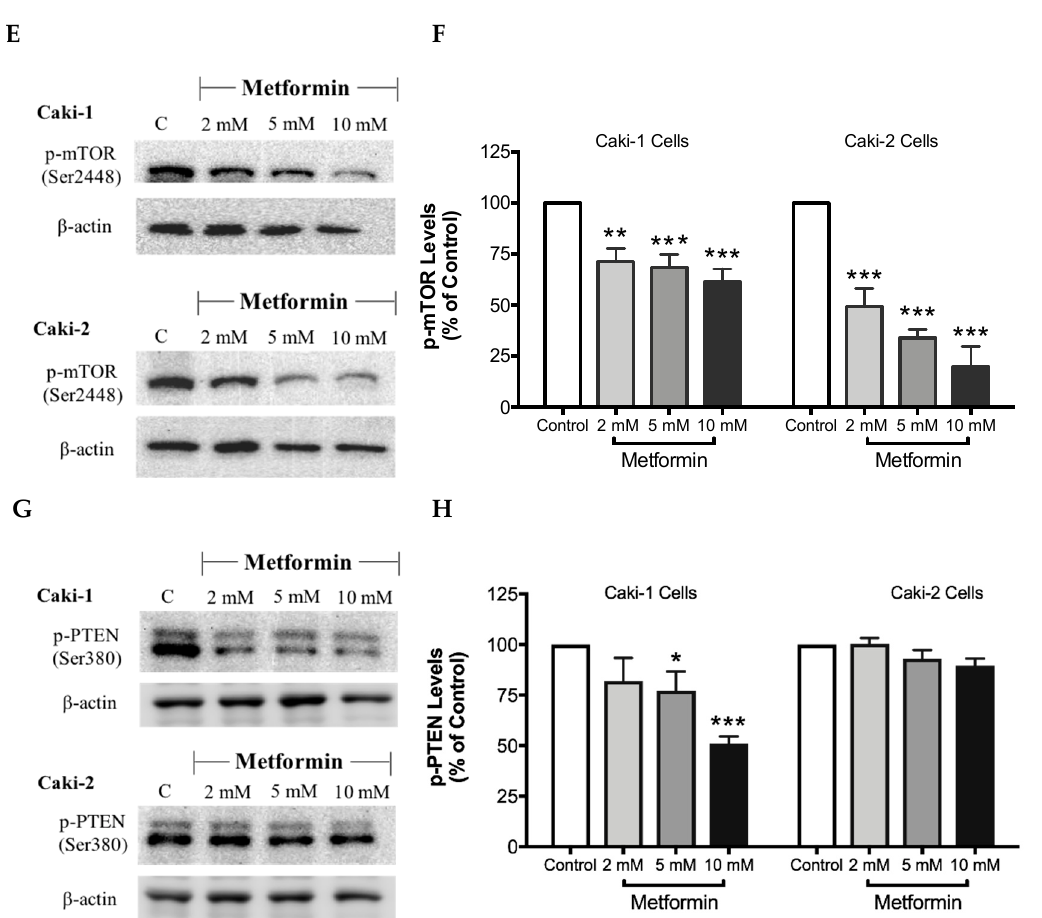
Figure 6. Metformin activated AMPK and reduced the activation of the Akt/mTOR axis in both Caki-1 and Caki-2 renal cancer cells. Western blot analyses are shown for ( A,B ) p-AMPK (Thr172), ( C , D ) p-Akt (Ser473), ( E,F ) p-mTOR (Ser2448), and ( G,H ) PTEN (Ser380) in Caki-1 and Caki-2 cells incubated in the absence (control) or presence of metformin (2, 5, and 10 mM). Images are representative of three independent experiments per group. ( B,D,F,H ) Histograms represent pooled densitometry data normalized to β -actin expressed as the percentage of control. Data are presented as mean ± SEM. * P < 0.05; ** P < 0.001; and *** P < 0.0001 vs. control.